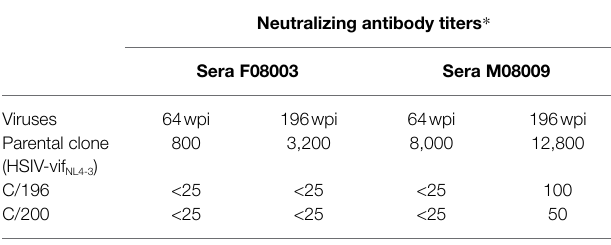
* The neutralizing antibody titer is the reciprocal of the serum dilution that inhibits infection by 50%